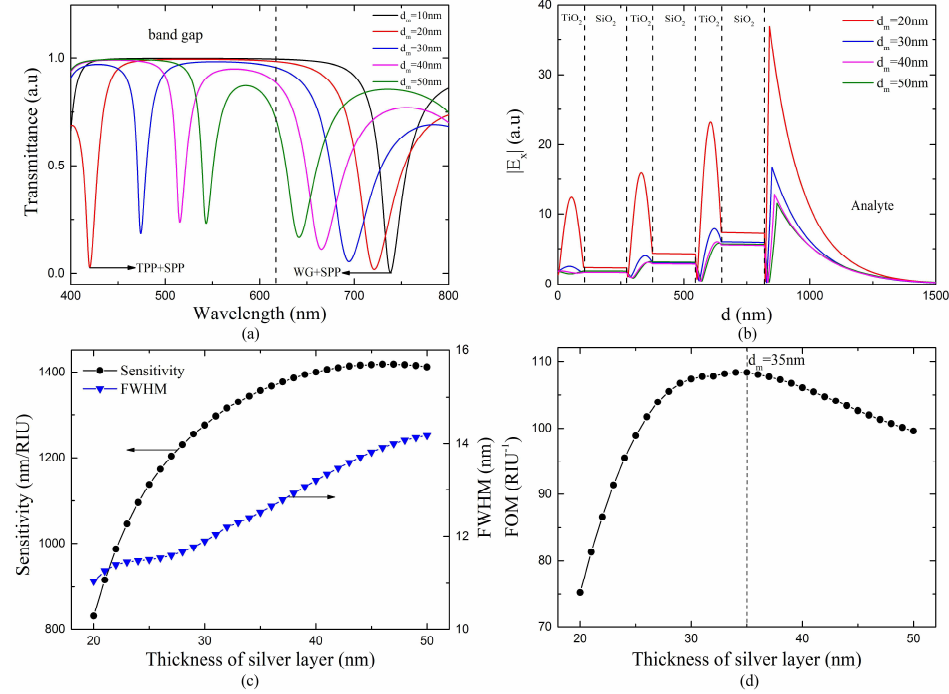
Figure 6. ( a ) Transmission spectra of the proposed sensor with different thickness of silver layer at n s = 1.37, N = 3, λ 0 = 1000 nm. ( b ) Tangential electric field distribution of TPP-SPP dip at the resonance wavelength 420 nm and the resonance angle of 88.63 ◦ , 474 nm and 87.77 ◦ , 516 nm and 87.43 ◦ , 543 nm and 87.24 ◦ for d m = 20 nm, 30 nm, 40 nm, 50 nm, respectively. ( c ) The variations of sensitivity and FWHM of the proposed sensor versus the silver layer thickness at n s = 1.37. ( d ) The variation of FOM versus the silver layer thickness at n s = 1.37.